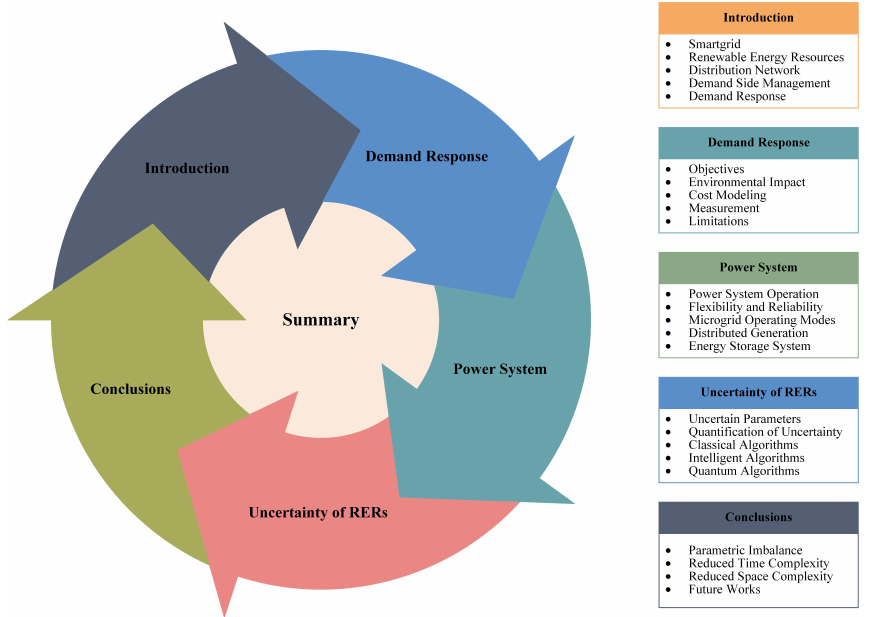
Figure 3. Summary of the